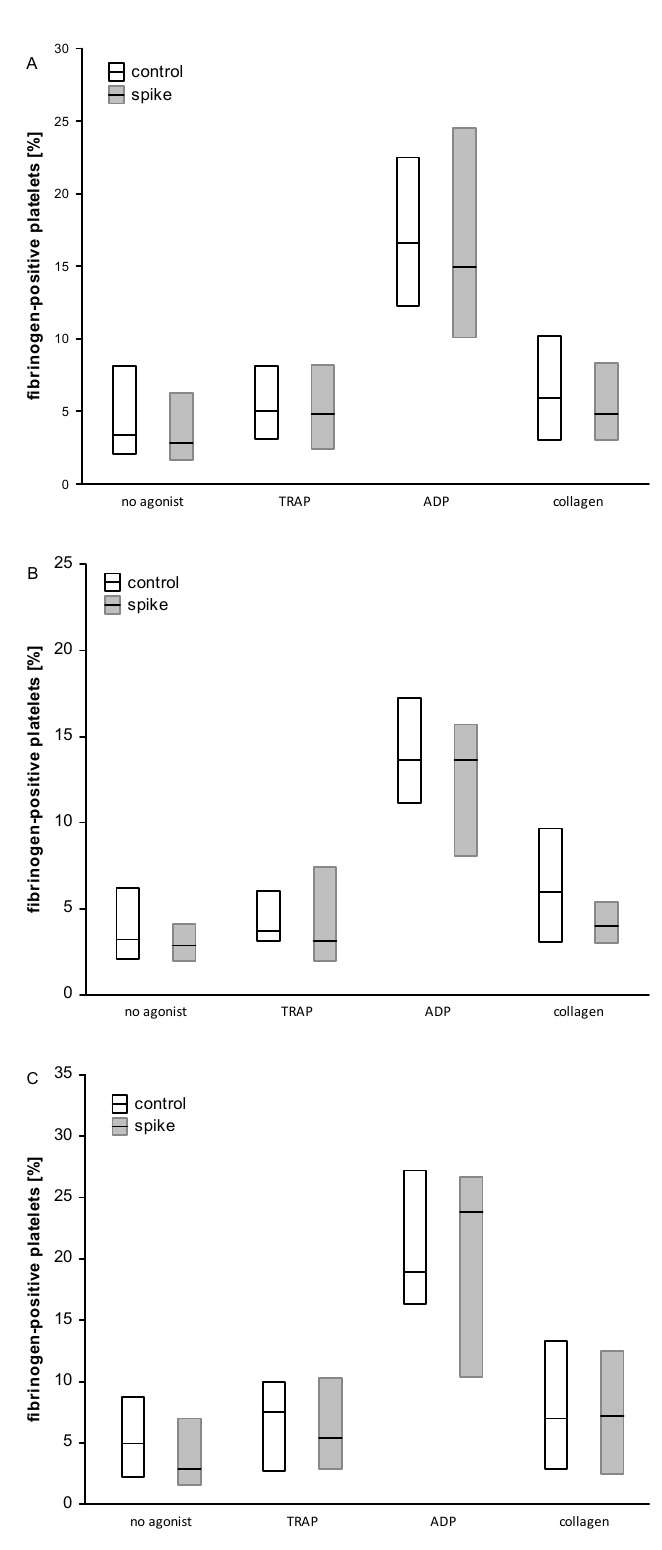
Figure 3. The effect of spike protein on the fibrinogen binding to platelets. Data are shown as median and interquartile range (Q1; Q3). The analysis was performed in all participants, n = 31 ( A ), in the High Ab-group, n = 13 ( B ), and in the Low Ab-group, n = 18 ( C ). No significant differences were observed between spike and control samples, irrespective of the concentration of nAb or the type of an agonist. The statistical significance of the differences between the control and spike samples was estimated with the bootstrap boosted-paired Student’s t -test.